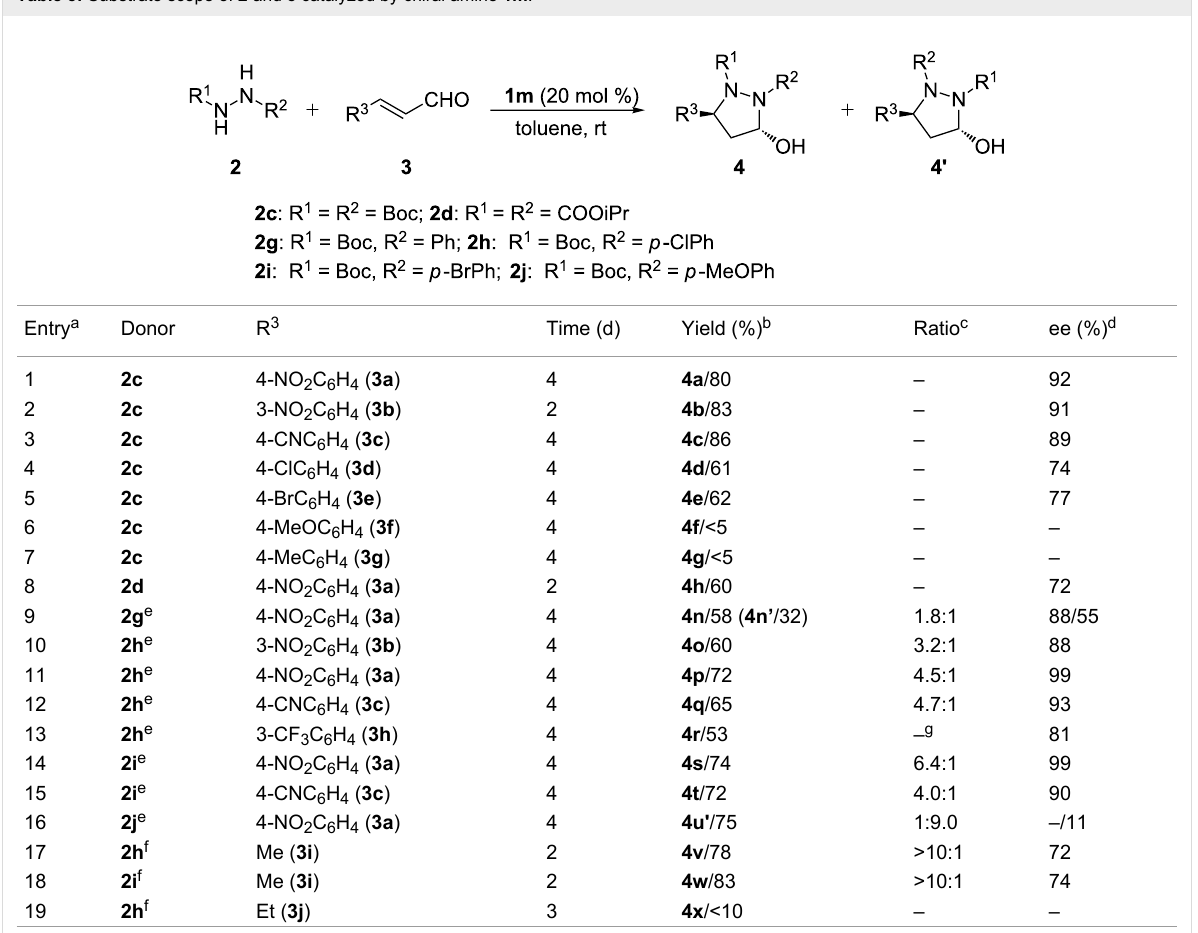
Table 5: Substrate scope of 2 and 3 catalyzed by chiral amine 1m